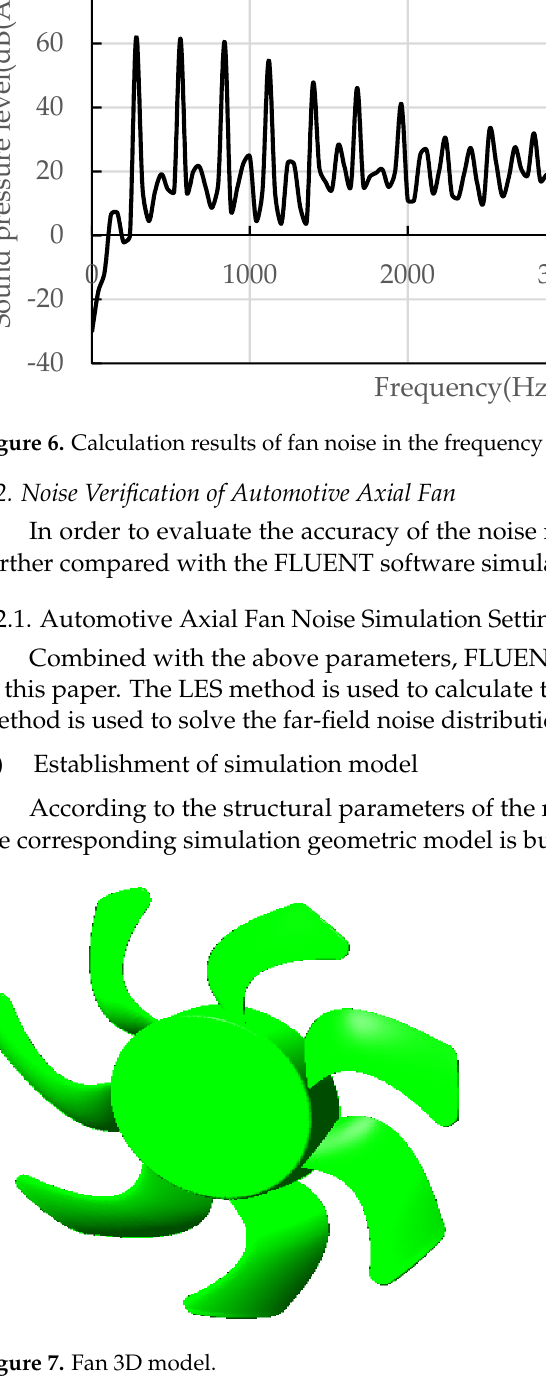
Figure 6. Calculation results of fan noise in the frequency domain.